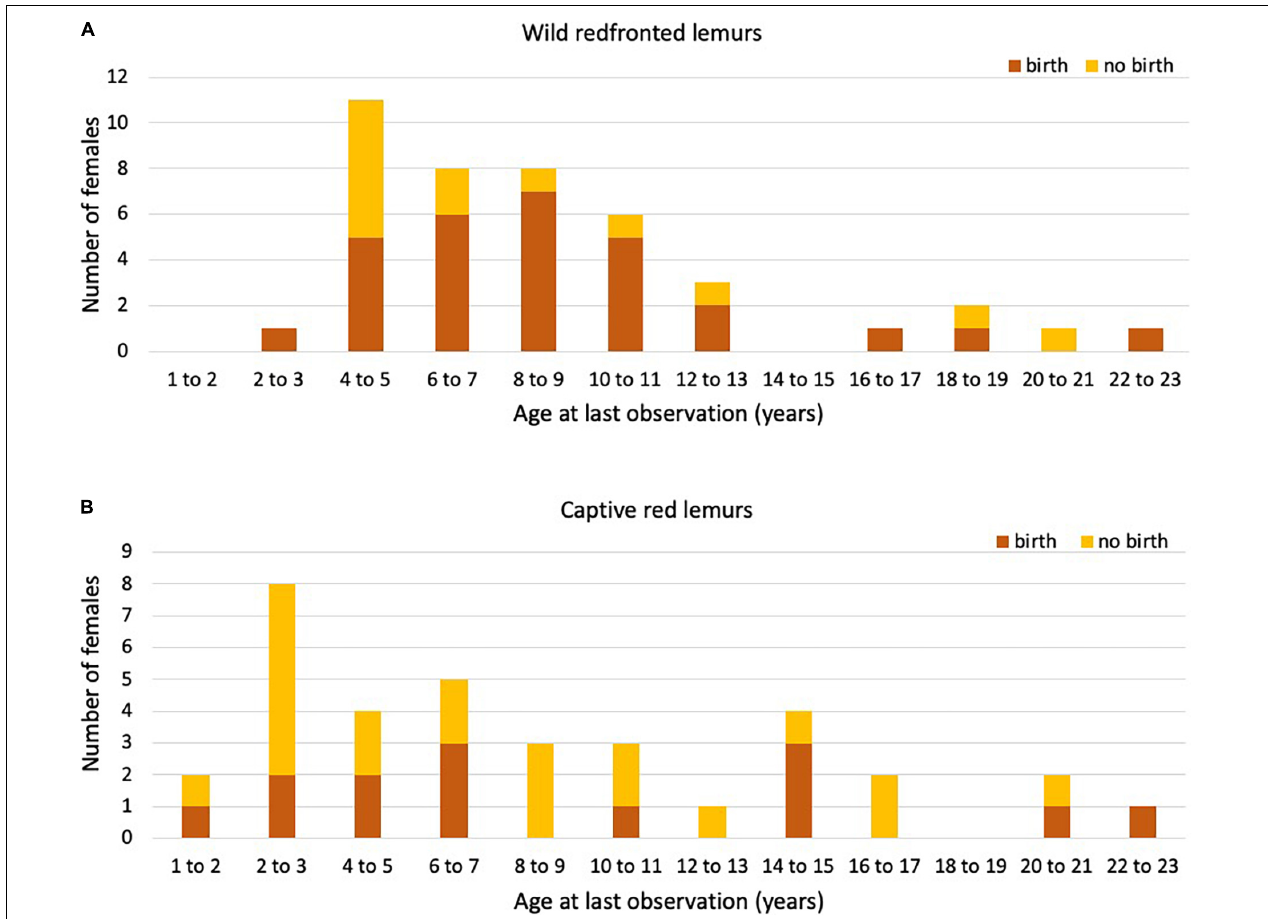
FIGURE 3 | Number of (A) wild redfronted and (B) captive red lemur females that gave birth (orange) or not (yellow) in their last year of life or observation (age in years).